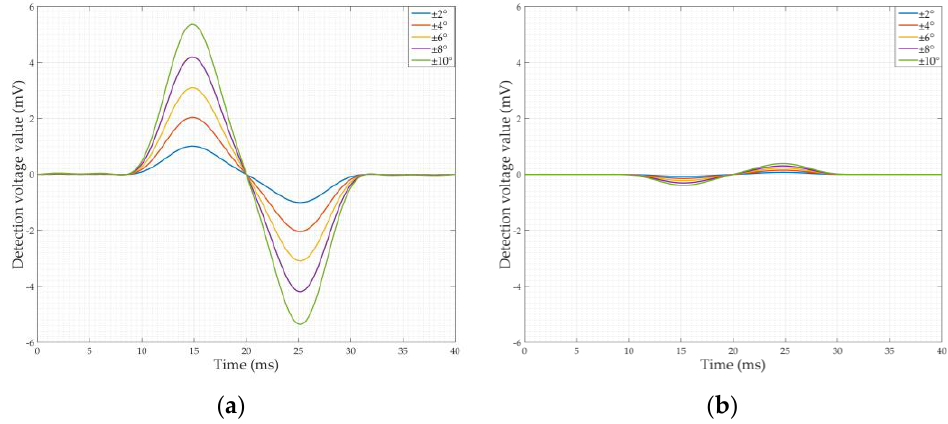
Figure 7. Simulation signals of sensor jitter: ( a ) In-phase components of the jitter signal; ( b ) Orthogonal components of the jitter signal.